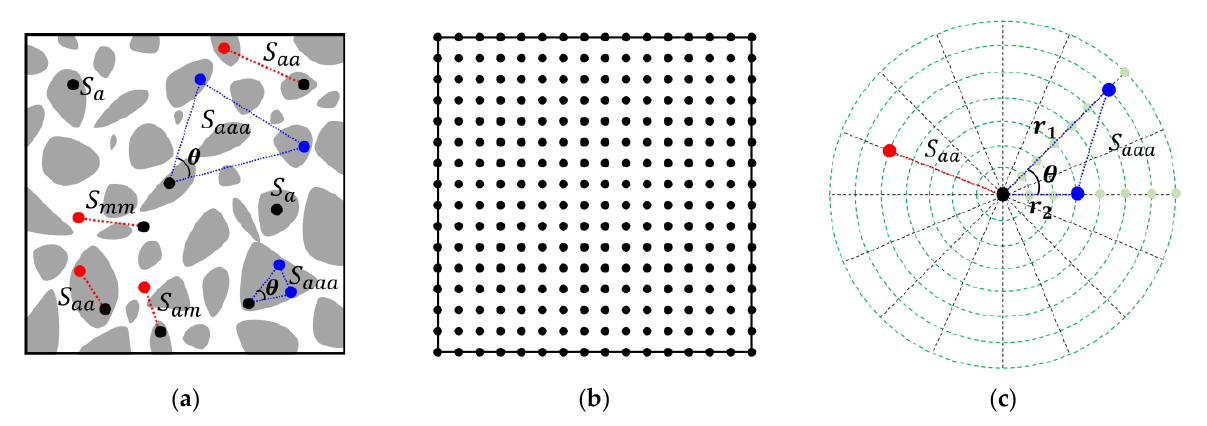
Figure 6. ( a ) Illustration of one-, two- and three-point correlation functions; ( b ) Systematic point sampling: uniformly arrayed sampling points; ( c ) Sampling lines and sampling triangles for two- and three-point correlation function, respectively.